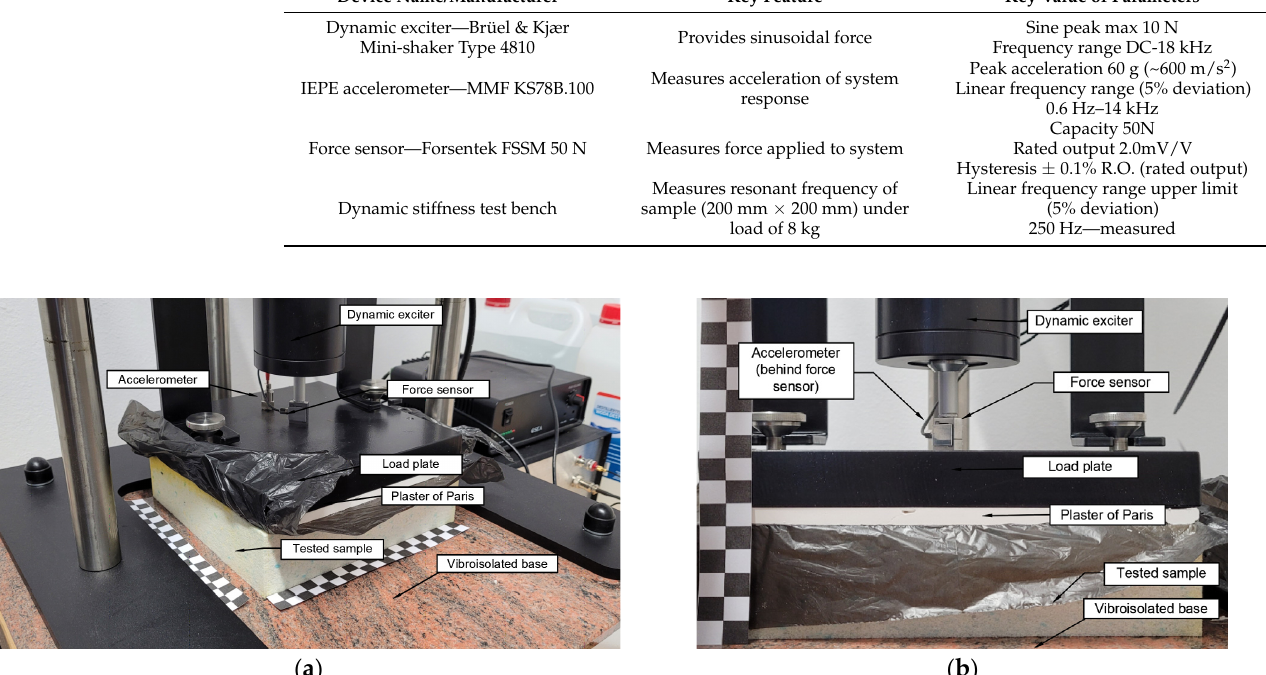
Figure 3. Dynamic stiffness testing machine for testing mass–spring–damper systems: ( a ) axonometry view; ( b ) front view. One tile on tile scale is 10 mm × 10 mm (own elaboration).